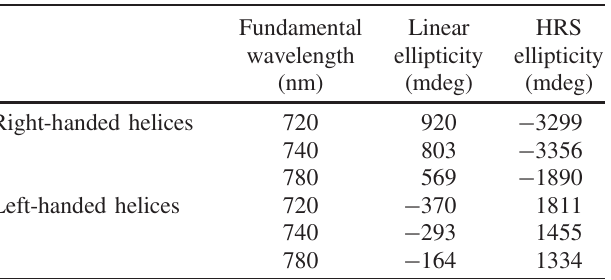
TABLE I. Linear and HRS ellipticities [obtained from Eqs. (1) and (2), respectively], for left- and right-handed nanohelix suspensions. Values are given at the three fundamental wave- lengths used in the HRS